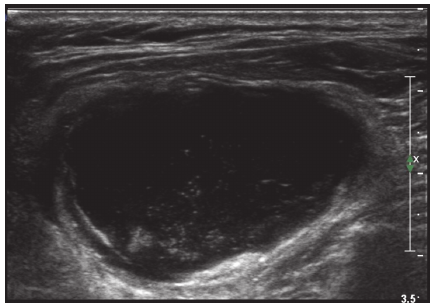
Figure 1: Ultrasonography showing a large heterogeneously echoic mass.